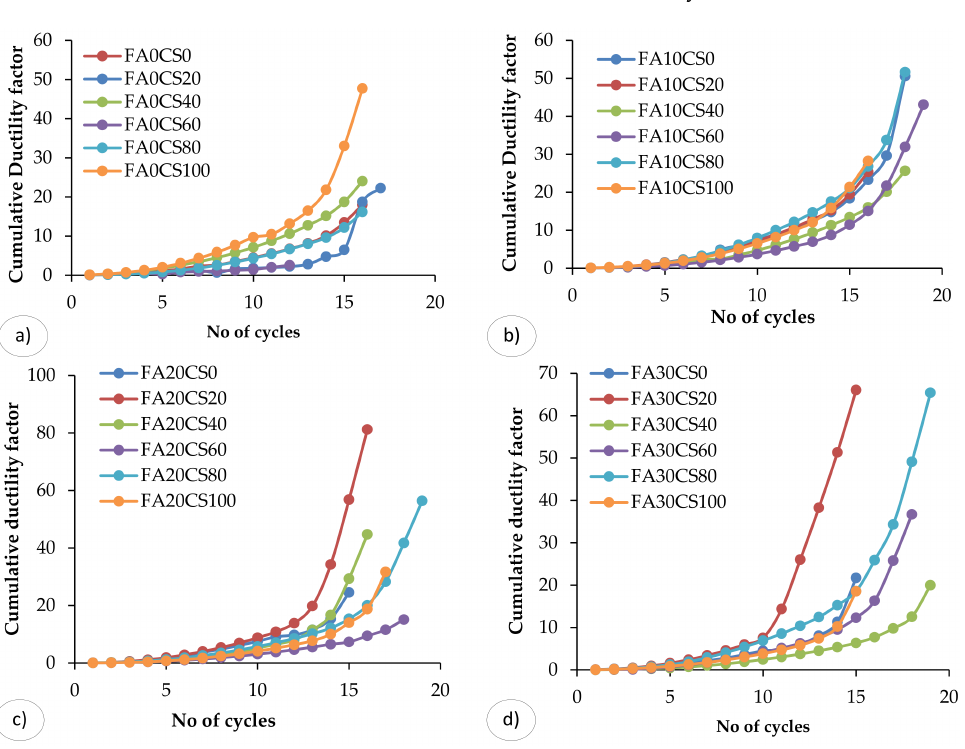
Figure 11. Cumulative ductility factor versus no. of cycles: ( a ) 0%FA and 0–100%CS, ( b ) 10%FA and 0–100%CS, ( c ) 20%FA and 0–100%CS, ( d ) 30%FA and